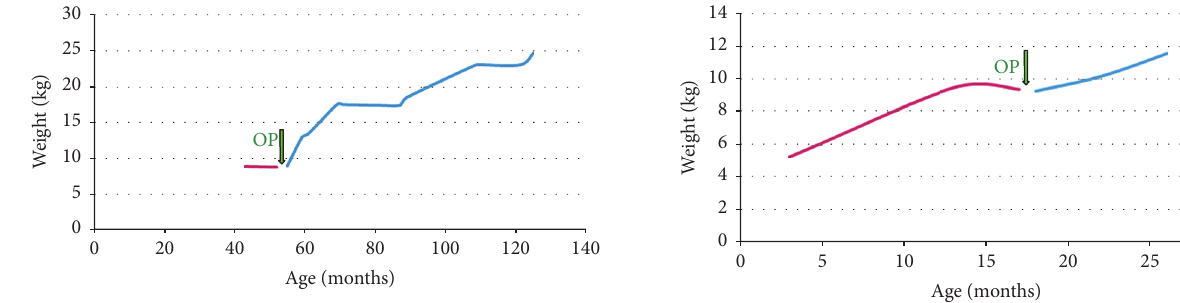
Figure 10: Weight development in patient 7 suffering from progres- sive encephalopathy caused by intractable epilepsy.